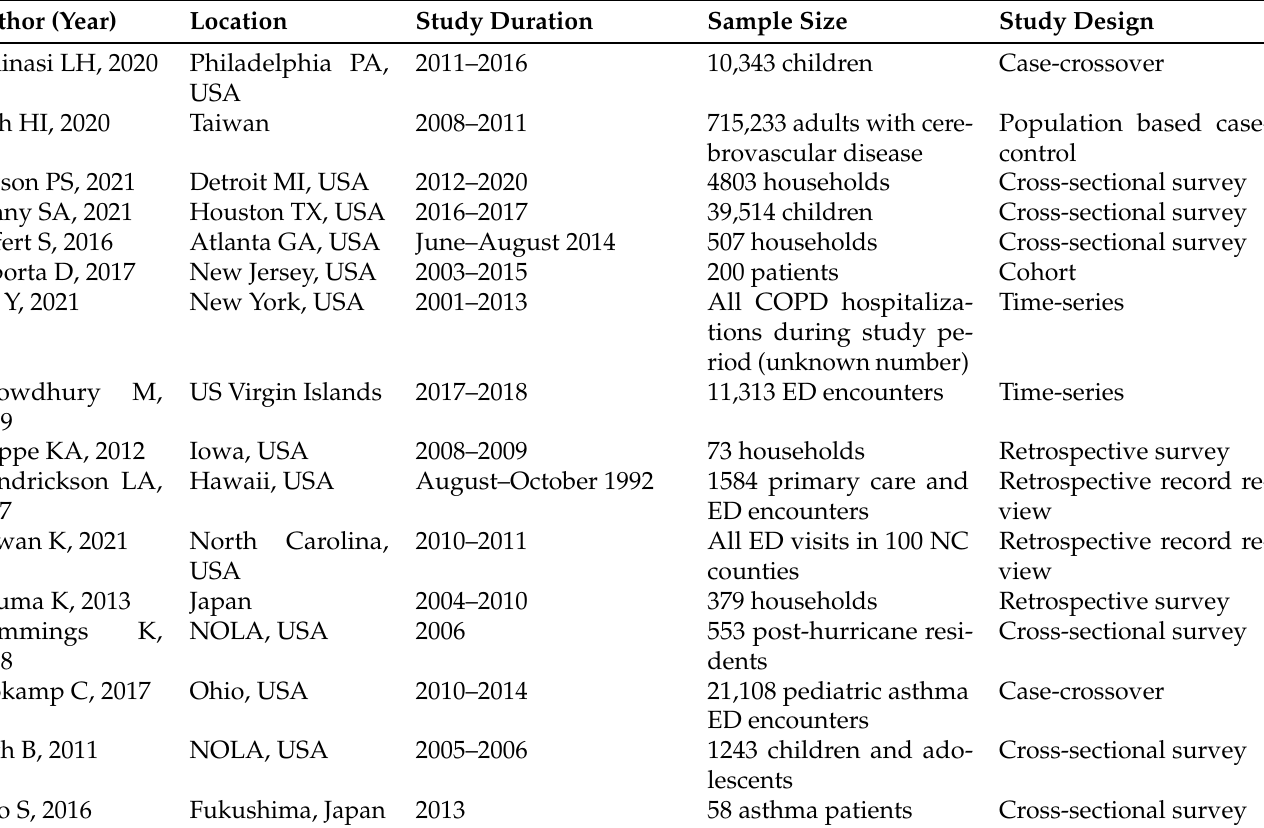
Table 2. Study location, duration, sample size and study design for all included